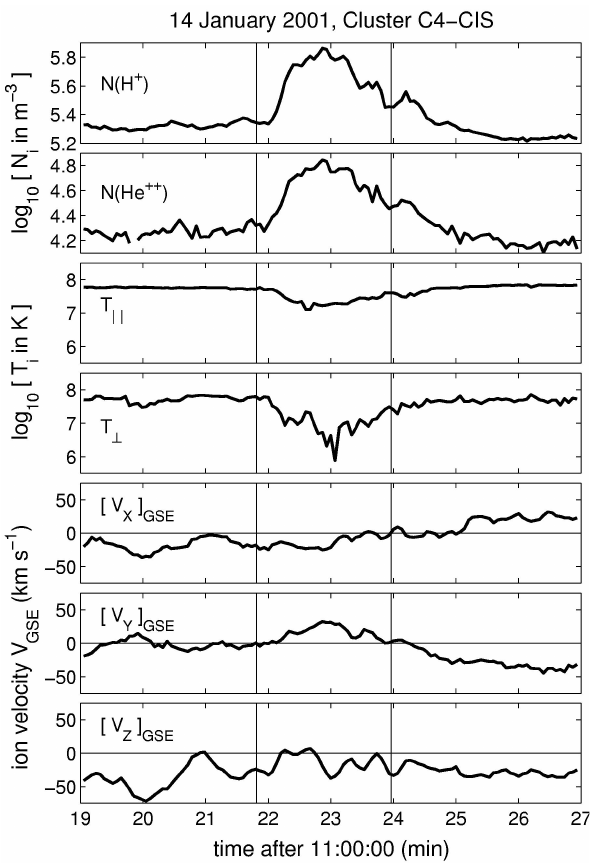
Fig. 9. The moments of the ion gas from spacecraft C3 for the interval shown in Fig. 8. The panels show: (a) the proton number density, N(H + ); (b) the alpha particle number density, N(He ++ ); (c) the field-parallel ion temperature, T || ; (d) the field-perpendicular ion temperature, T ⊥ ; and the ion velocity components (e) V X , (f) V Y , and (g) V Z , in GSE coordinates.